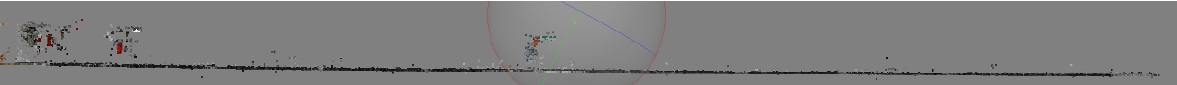
Figure 7. Sony α7R2 not perfectly aligned due to homogeneous object.